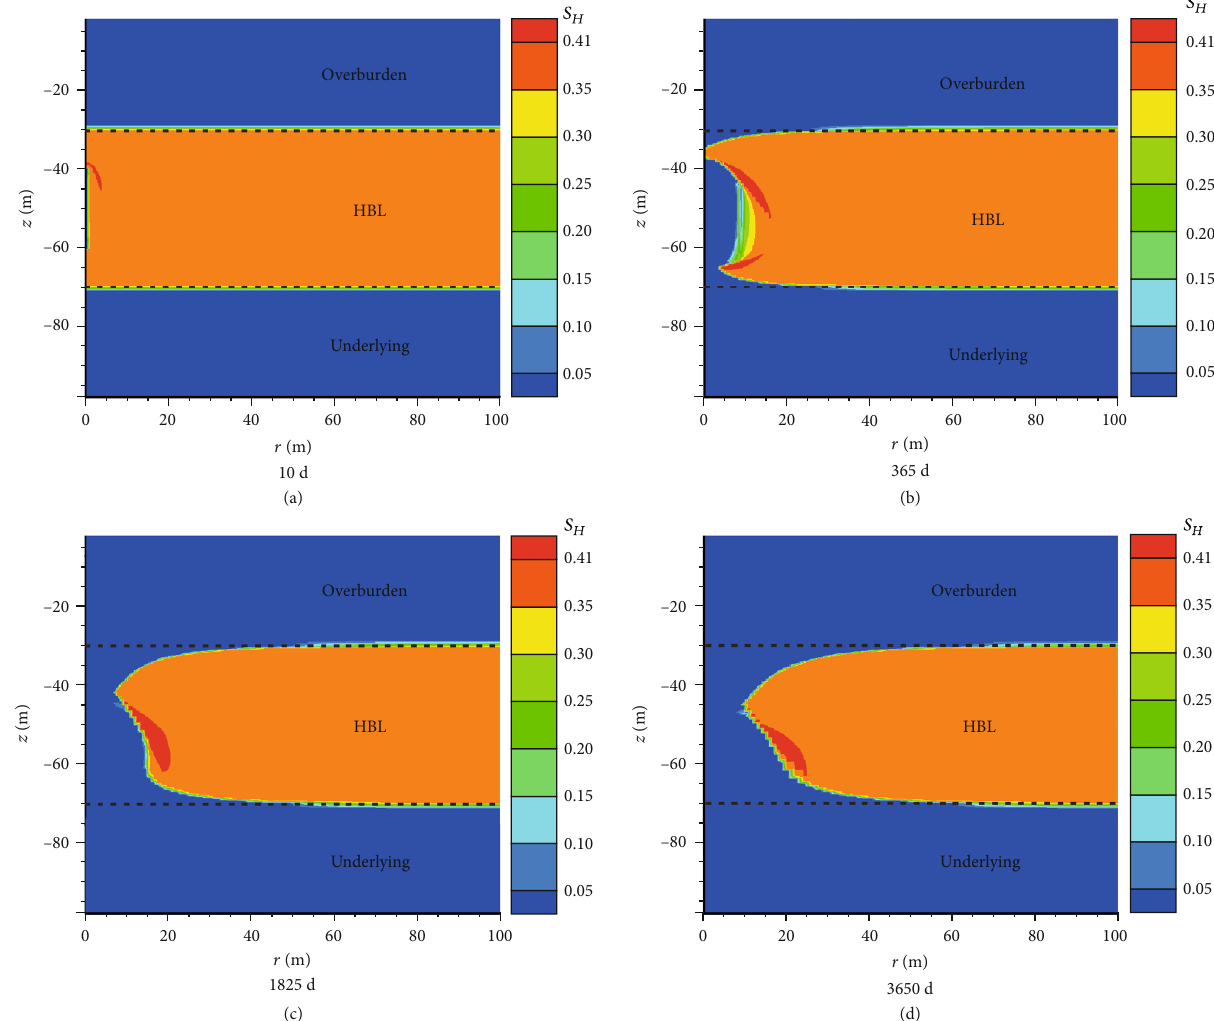
on the 10 th day, 365 th day, 1825 th day, and 3650 th day in the case with H